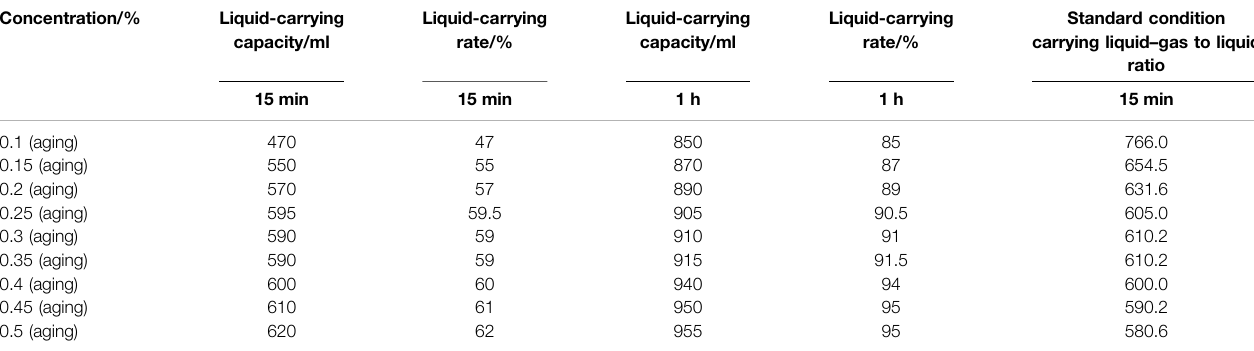
TABLE 6 | Liquid-carrying capacity of AES at different concentrations.